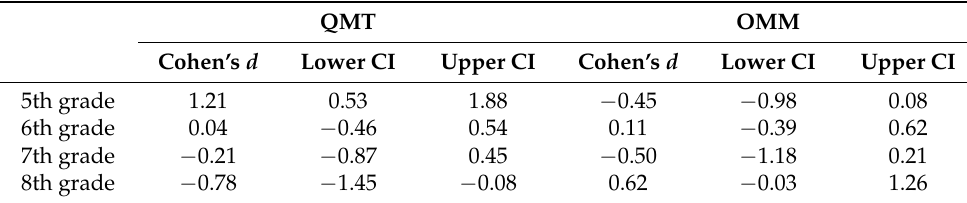
Table 2. Effect size (Cohen’s d) and 95% confidence intervals for ∆ Fluency following QMT (left) and OMM (right) in each